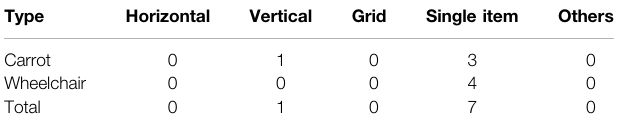
TABLE 2 | Additional pages design layouts.